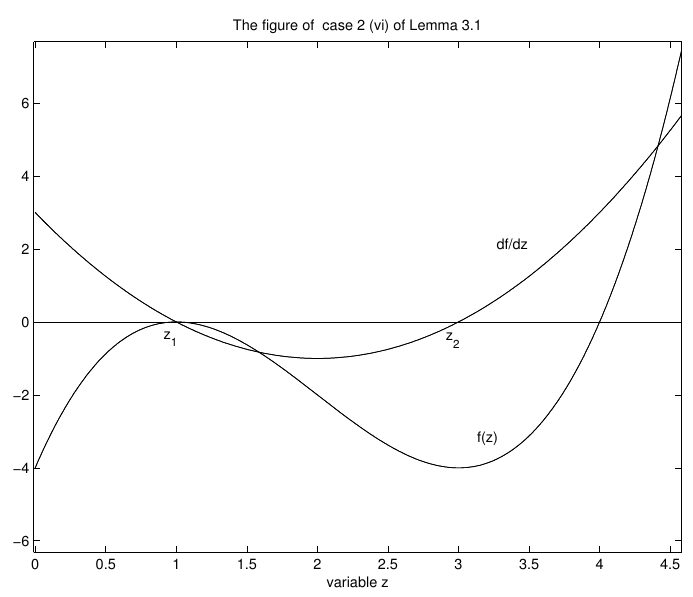
Figure 1. The figure of case 2